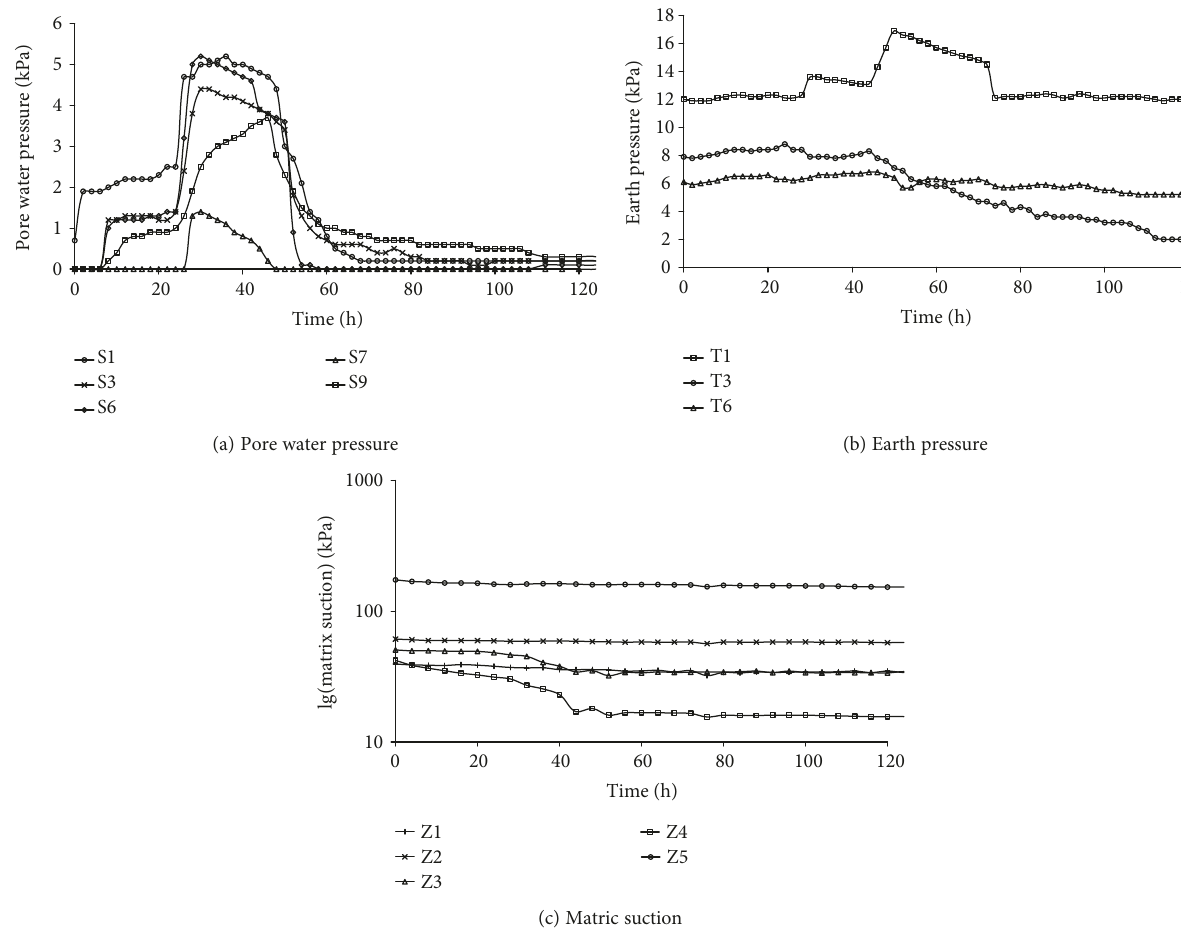
Figure 7: Results during the impoundment period.